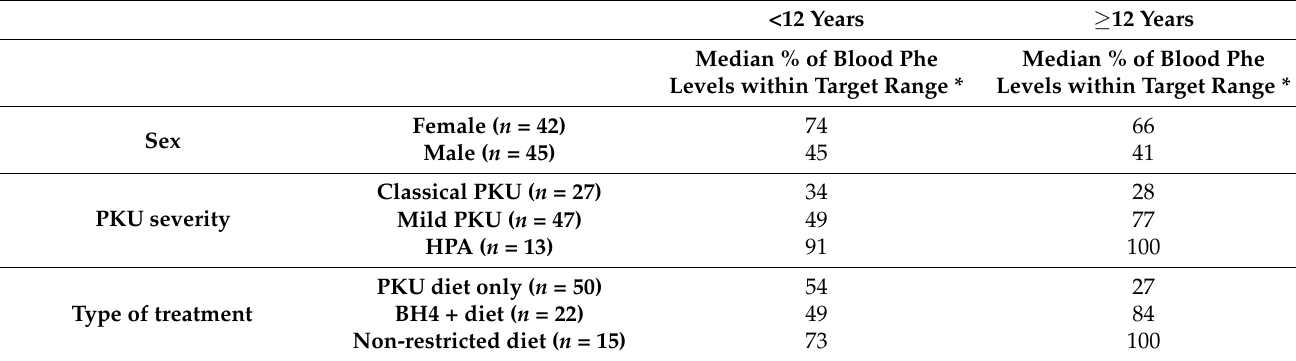
Table 3. Median percentage of blood Phe measurements within target range recommended by the Portuguese consensus.